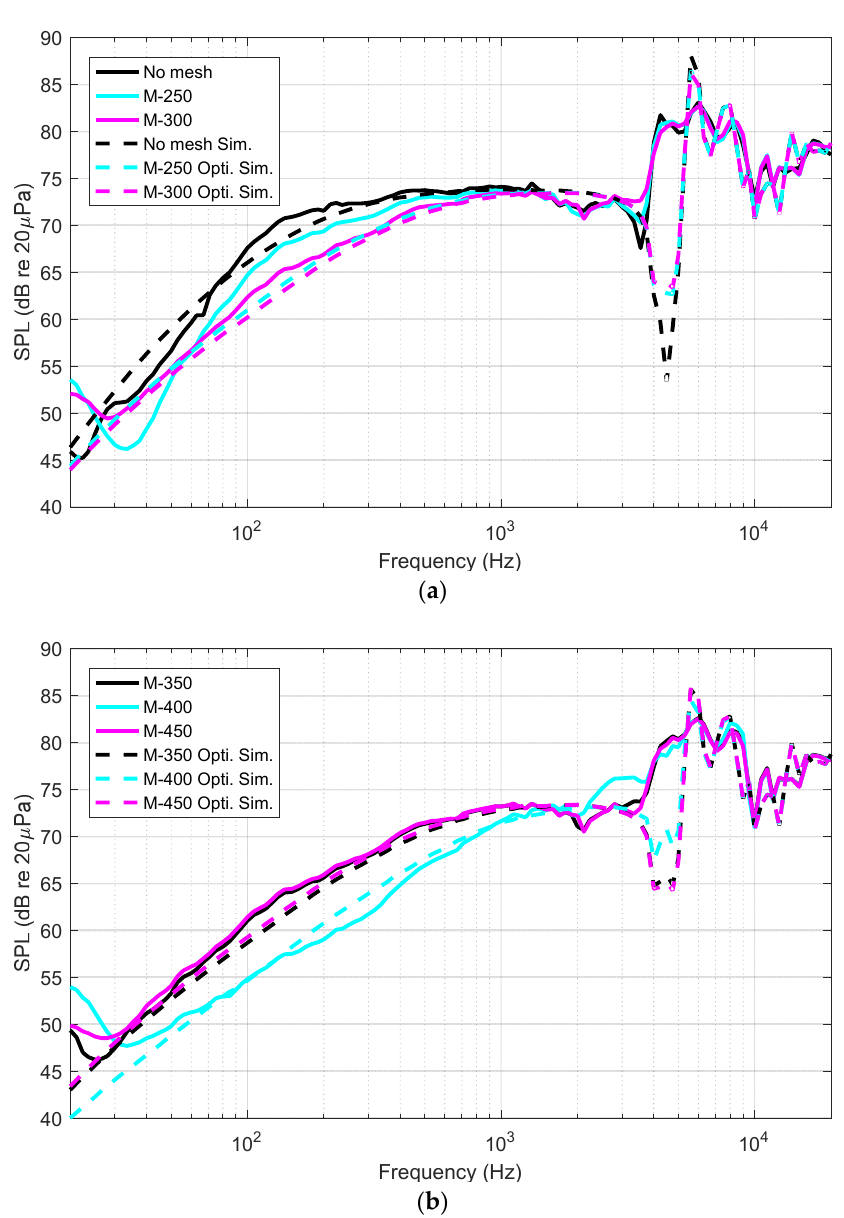
Figure 11. ( a ) Measured and simulated frequency responses of microspeaker with meshed ventilation cloths (M-250 to M-300) and ( b ) Measured and simulated frequency responses of microspeaker with meshed ventilation cloths (M-350 to M-450).